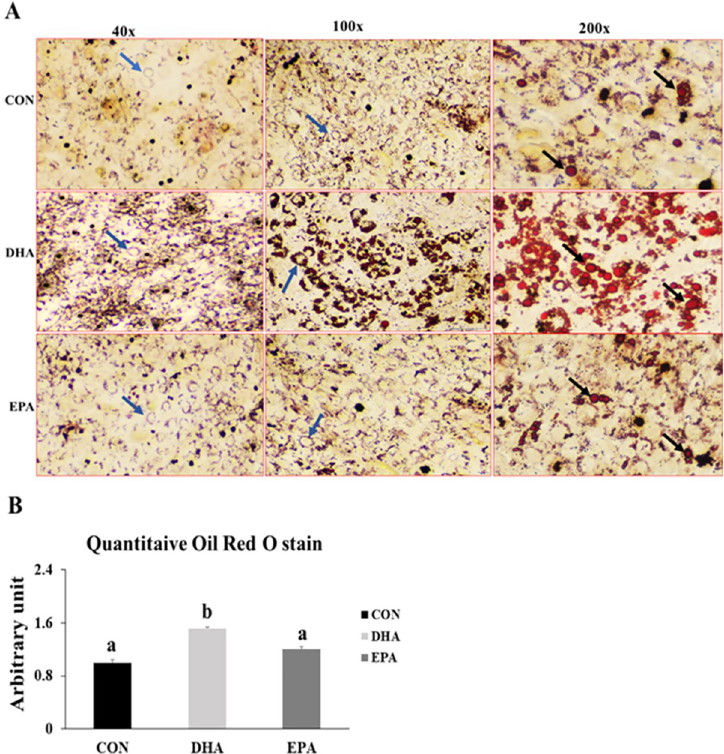
Fig 9. The effect of DHA and EPA on ETC regulating genes. C2C12 cells were treated with white adipogenesis induction differentiation medium (BIDM) in the absence (CON) or presence of individual doses of 50 μ M EPA and 50 μ M DHA for 7 days. All the values of RT-qPCR are normalized to the expression levels of 18s genes and calculated in arbitrary units, n = 6. Data are represented as mean ± SEM. The significant difference is presented as � P < 0.05, Student’s t test. The level of GAPDH is used as a housekeeping gene to normalize the Western blots data. (A) Effect of DHA on the expression of ETC regulating genes. (B) Effect of EPA on the expression of ETC regulating genes.